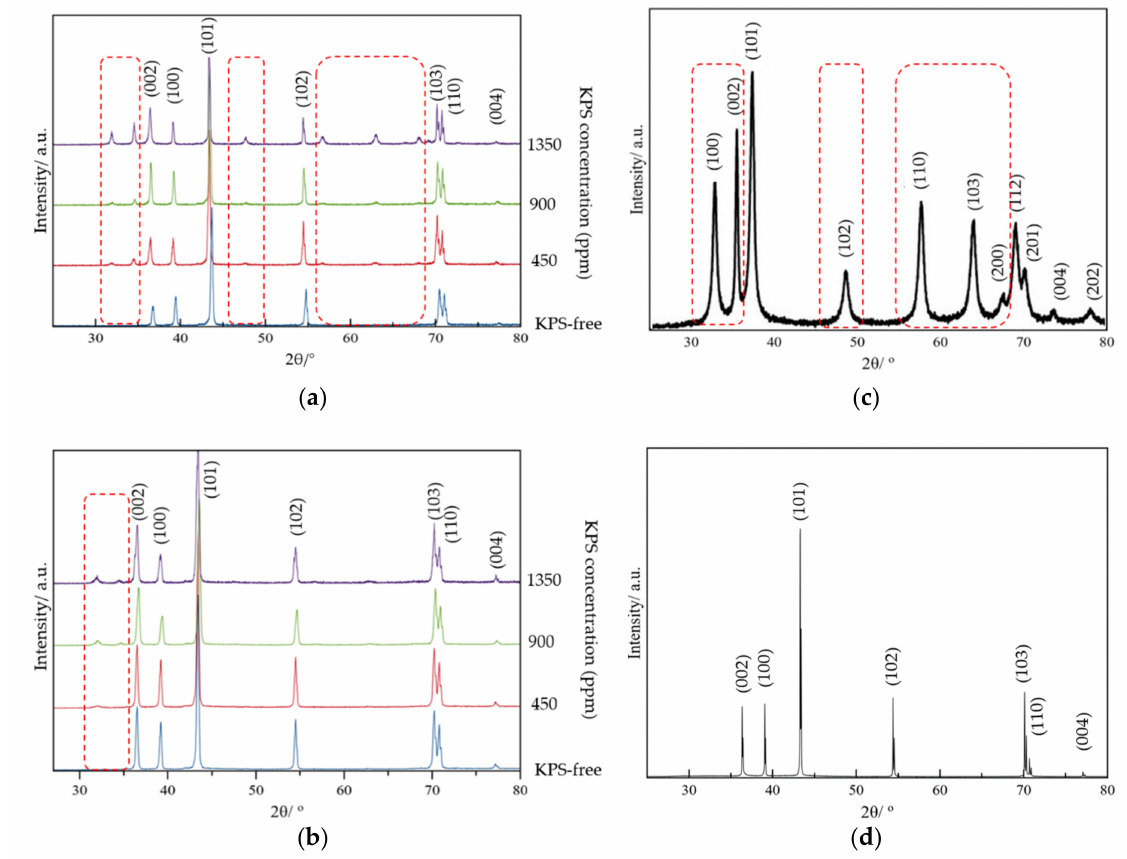
Figure 3. XRD patterns of ( a ) the Zn surface after 8 h immersion in electrolyte solution and 10 charge / discharge cycles at a current density of 15 mA / cm 2 at the state of discharge; ( b ) at the state of charge; ( c ) ZnO nanoparticles [33]; and ( d ) fresh pure Zn